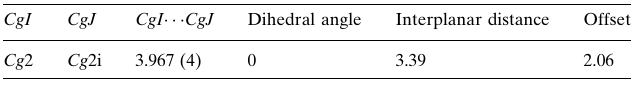
Table 2 (cid:2) – (cid:2) interactions (A˚ , (cid:2) ). Cg 2 is the centroid of ring C22–C27. The offset is defined as the distance between CgI and the perpendicular projection of CgJ on ring I